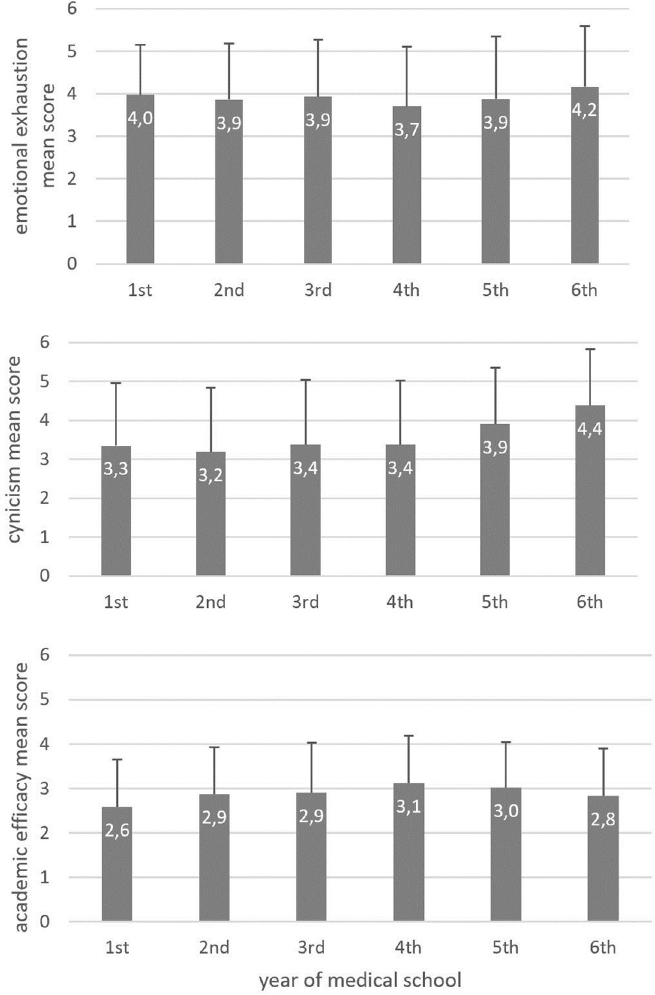
Fig 3. Mean burnout scores in each dimension among students of different years of medical